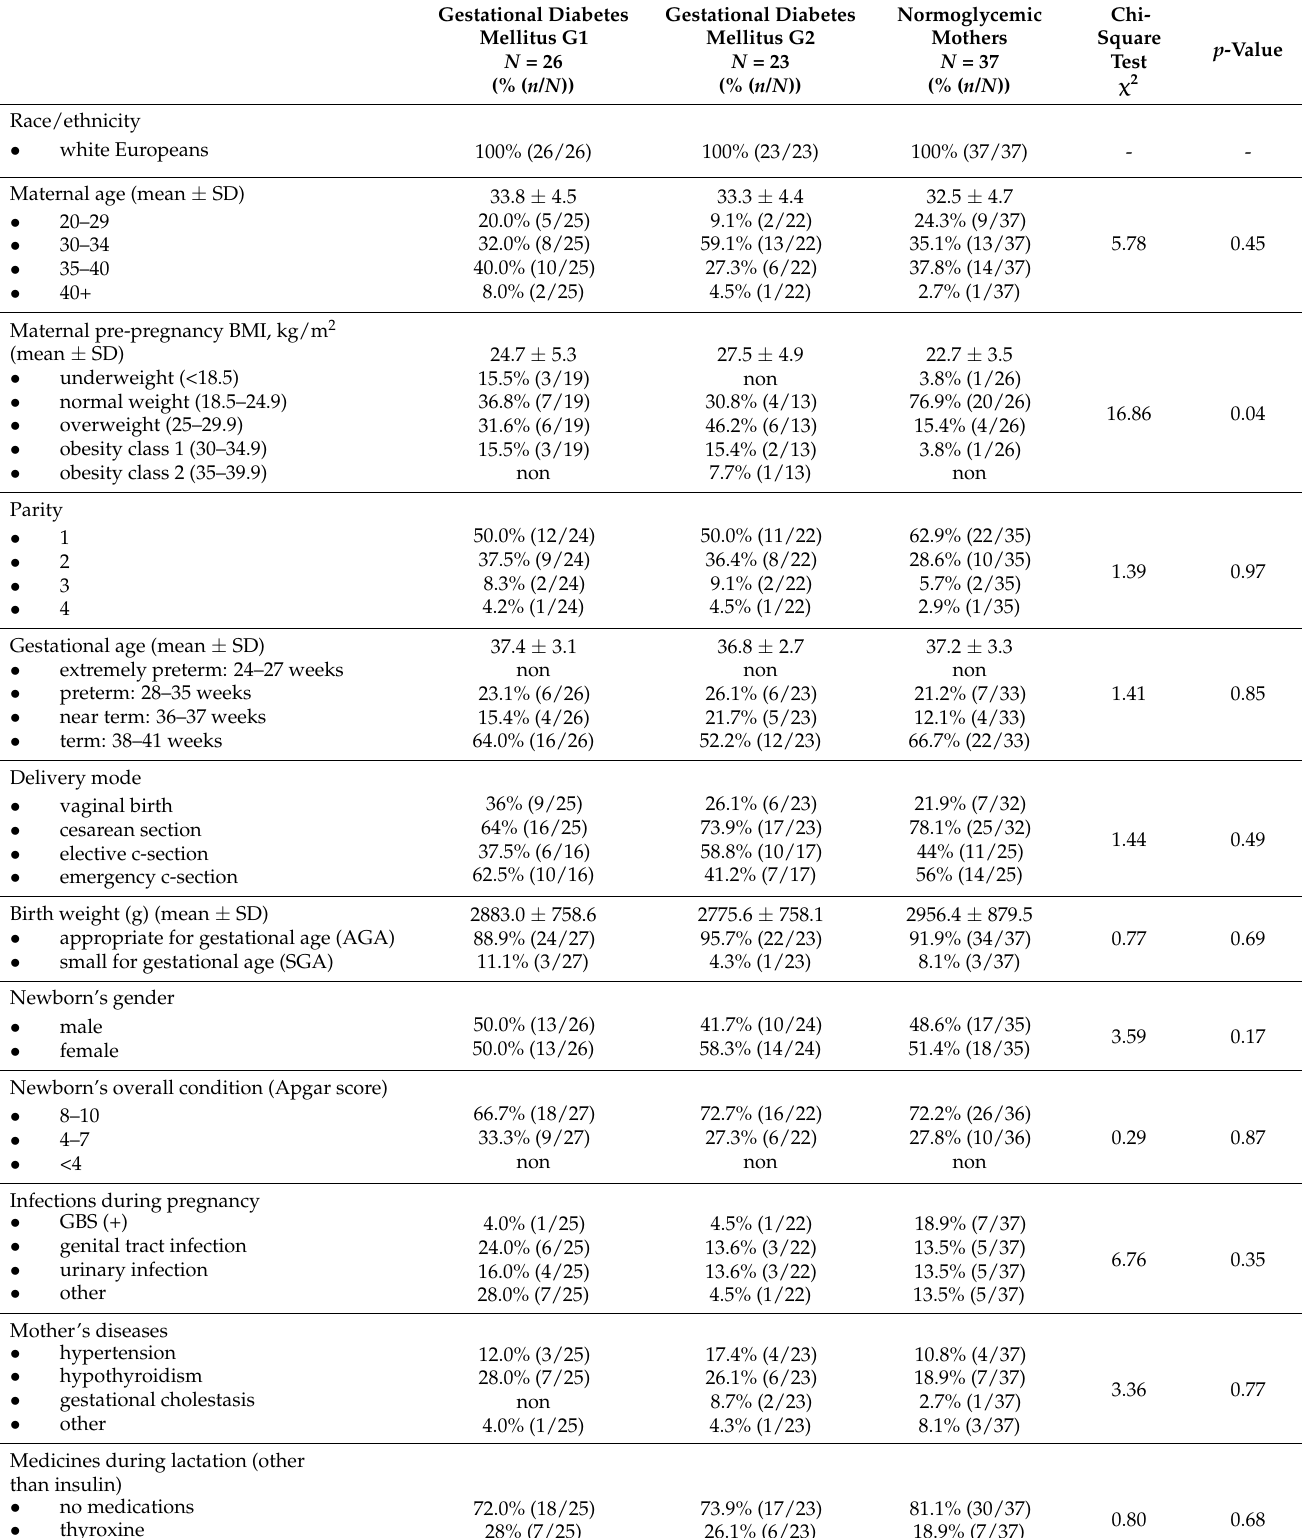
Table 1. Characteristics of the study